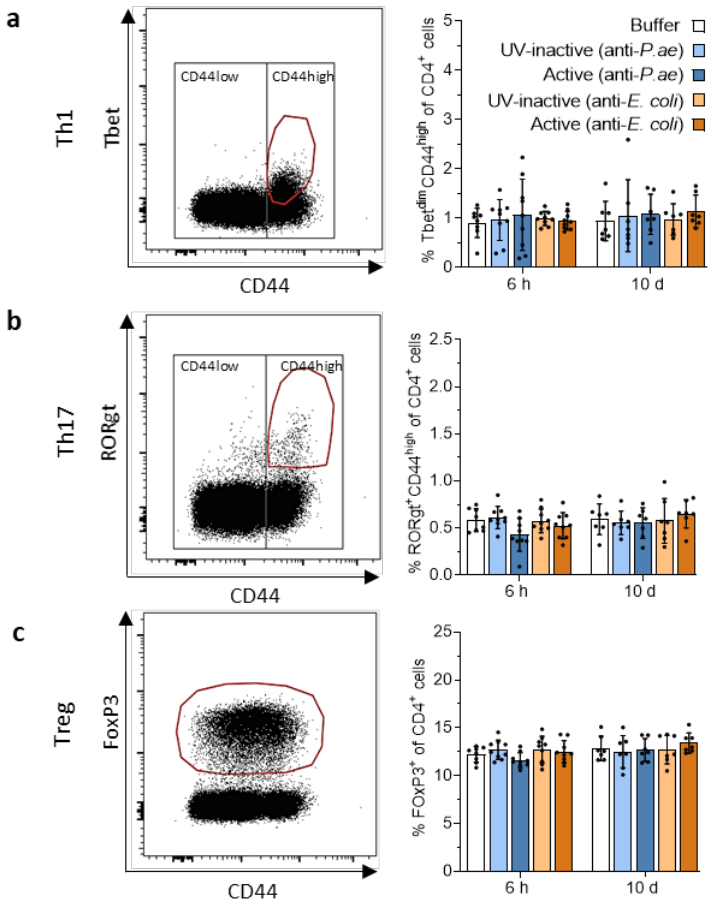
Figure 6. T-helper cell populations in the draining lymph nodes show no marked changes post-phage treatment. Analysis of the effector T-cell subsets ( a ) Th1, ( b ) Th17 and ( c ) Treg in the lymph nodes. Shown are representative dot plots (left) and bar graphs depicting the percentage of remaining cells (right). Results are shown as mean ± SD, as determined by 2-way ANOVA with Tukey ’ s multiple comparisons test: n = 7 – 9 mice per group. For full gating strategy and cell type identifying markers see Figure S2.